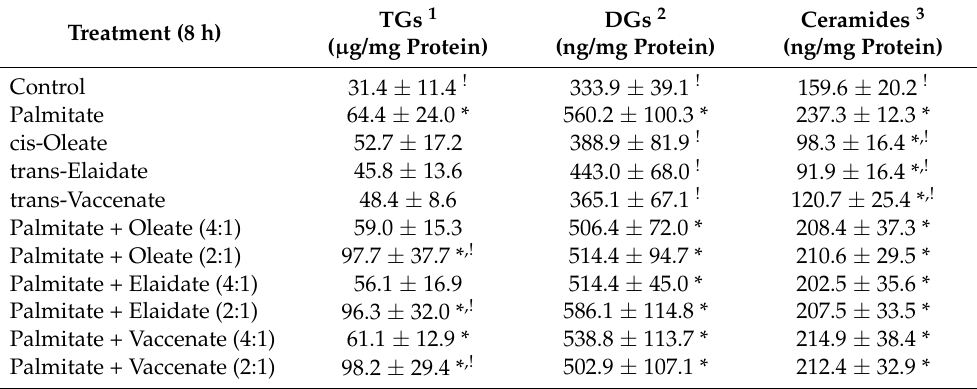
Table 1. Overall triglyceride, diglyceride and ceramide contents of the cells treated with fatty acids at sub-toxic concentrations. Cells were treated with BSA-conjugated palmitate, oleate, elaidate or vaccenate (50 µ M) or with palmitate (50 µ M) and oleate, elaidate or vaccenate at 4:1 or 2:1 molar ratio (12.5 or 25 µ M) at 70–80% confluence for 8 h. The overall amount of ten triglycerides, six diglycerides and three ceramides was measured by LC-MS/MS. Data were normalized to the total protein content of the samples and are shown as mean values ± S.D.; n ≥ 4; statistically significant differences: * p < 0.05 vs. BSA treated control; ! p < 0.05 vs. palmitate treated